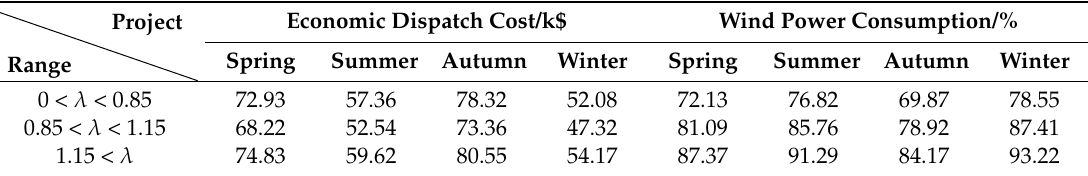
Table 6. Comprehensive cost and wind power consumption under each interval of green economic